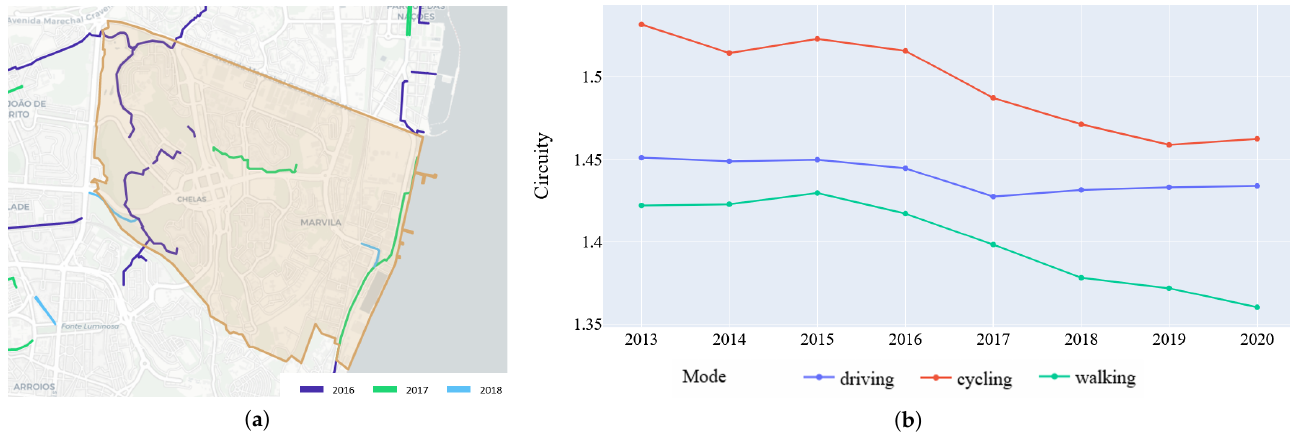
Figure 8. Cycling infrastructure changes from 2016 to 2018 in Lisbon’s parish of Marvila ( a ), and the evolution of the median circuity in Marvila ( b ).